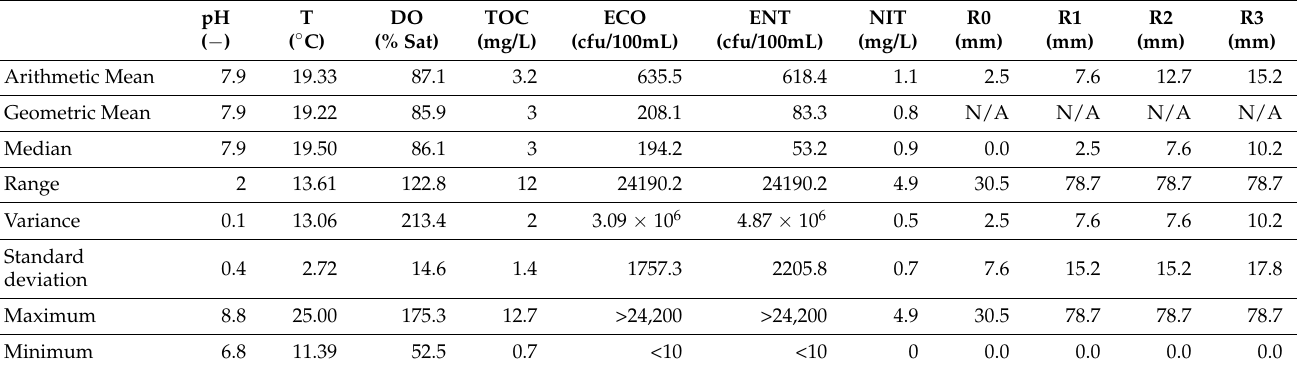
Table 2. General statistics ( n = 341